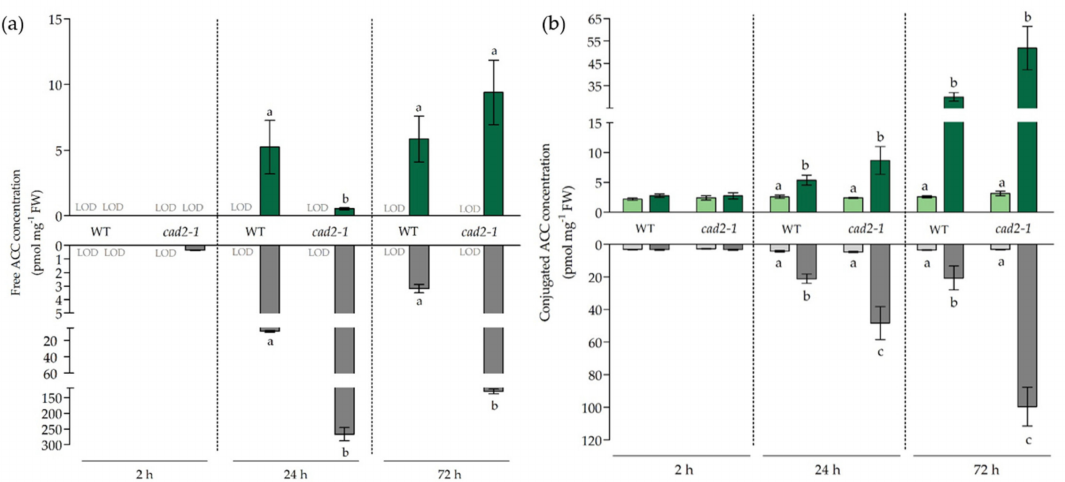
Figure 5. ( a ) Free and ( b ) conjugated 1-aminocyclopropane-1-carboxylic acid (ACC and ACCc) concentrations (pmol mg-1 fresh weight) in leaves and roots of 3-week-old wild-type (WT) and